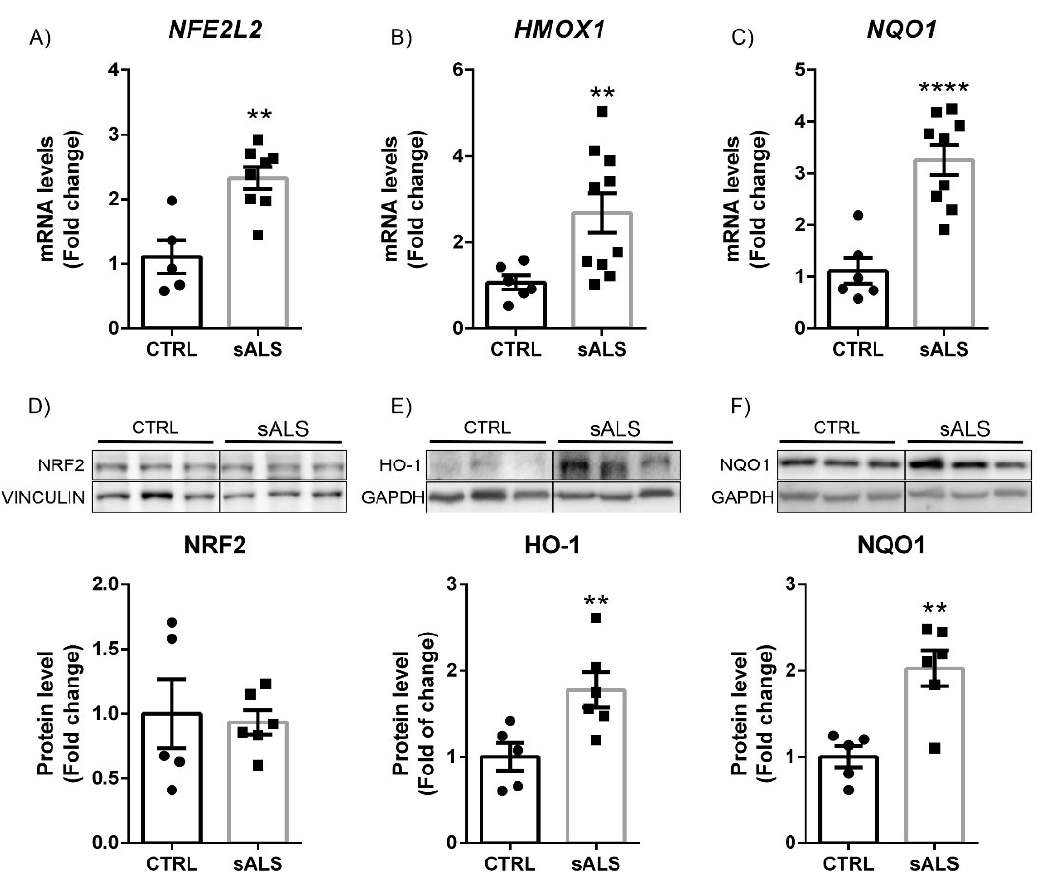
Figure 5. Increased HO-1 and NQO1 protein levels in lumbar spinal cord in sALS patients. Quantita- tive real-time PCR determination of mRNA levels of ( A ) NFE2L2 , ( B ) HMOX1 , and ( C ) NQO1 . All genes were normalized by TBP (TATA box binding protein) mRNA levels; n = 6–8 samples ± SEM. Asterisks denote significant differences at ** p < 0.001 and **** p < 0.0001 when comparing sALS to control patients according to the Student’s t -test. Protein levels of ( D ) NRF2, ( E ) HO-1, and ( F ) NQO1 were analyzed by immunoblotting and their respective protein quantifications; n = 5–6 samples per experimental group ± SEM. Asterisks show significant differences at ** p < 0.001 when comparing groups according to the Student’s t ‐ test.